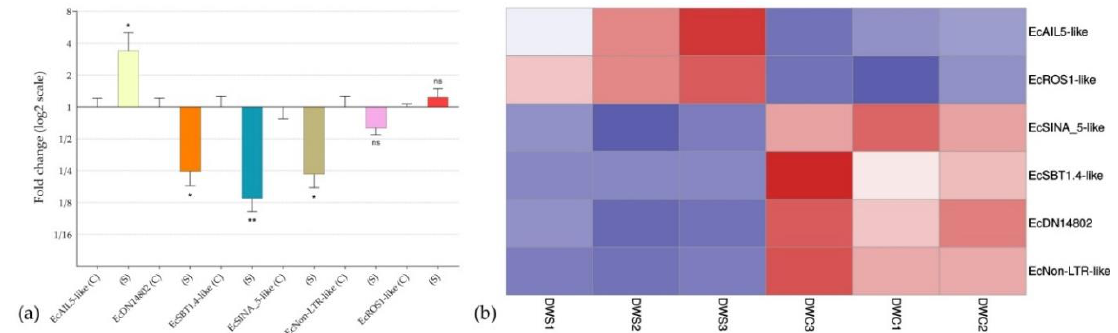
Figure 4. ( a ) qRT-PCR validation and ( b ) the Heatmap of weeping lovegrass selected for differentially expressed genes between the control (C) and water-stressed (S) plants. * Indicates significant or highly significant differences (**); ns indicates nonsignificant differences between treatments.